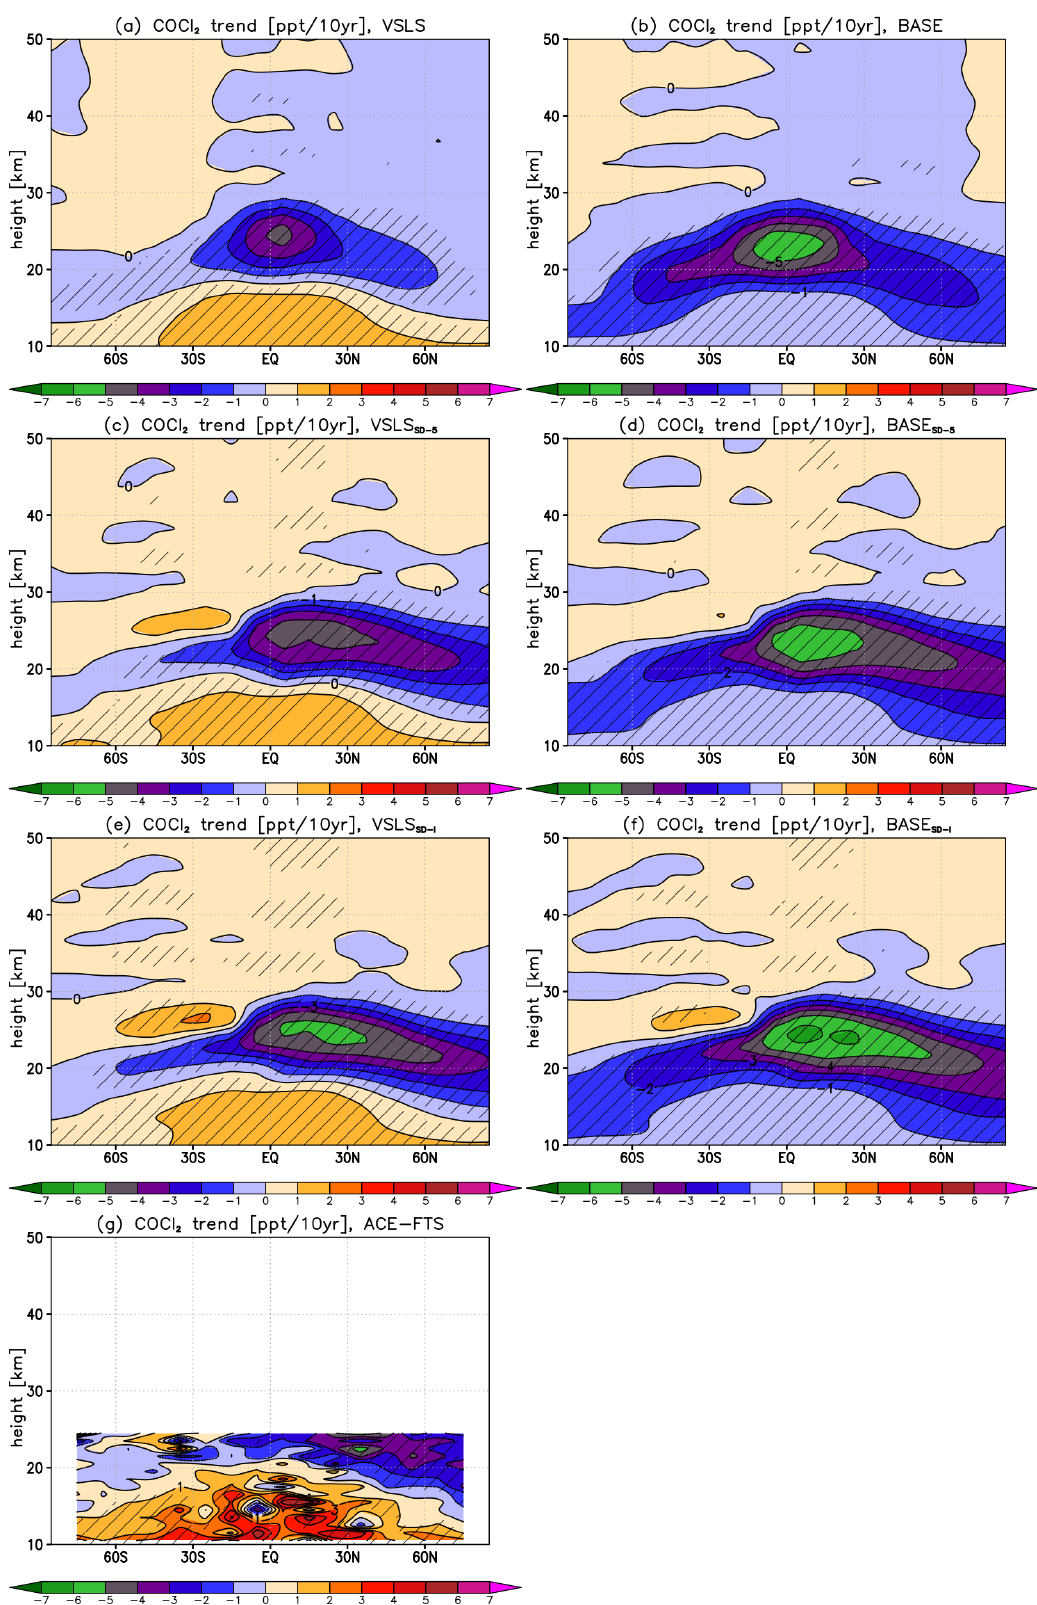
Figure 12. As in Fig. 8 but for linear trends in deseasonalised COCl 2 mixing ratios [ppt per 10 years]. Atmos. Chem. Phys., 22, 10657–10676, 2022